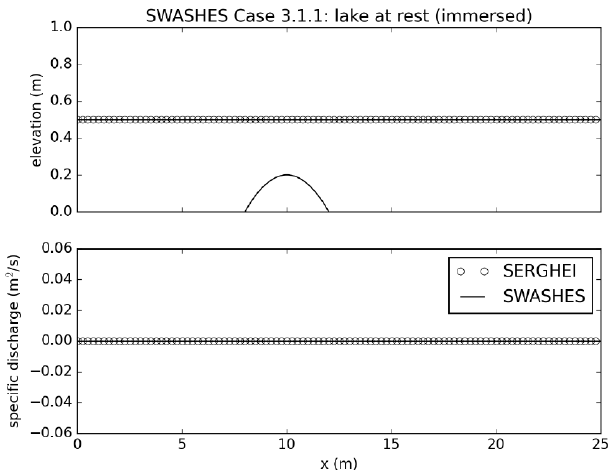
Figure A1. Lake-at-rest solution for an immersed